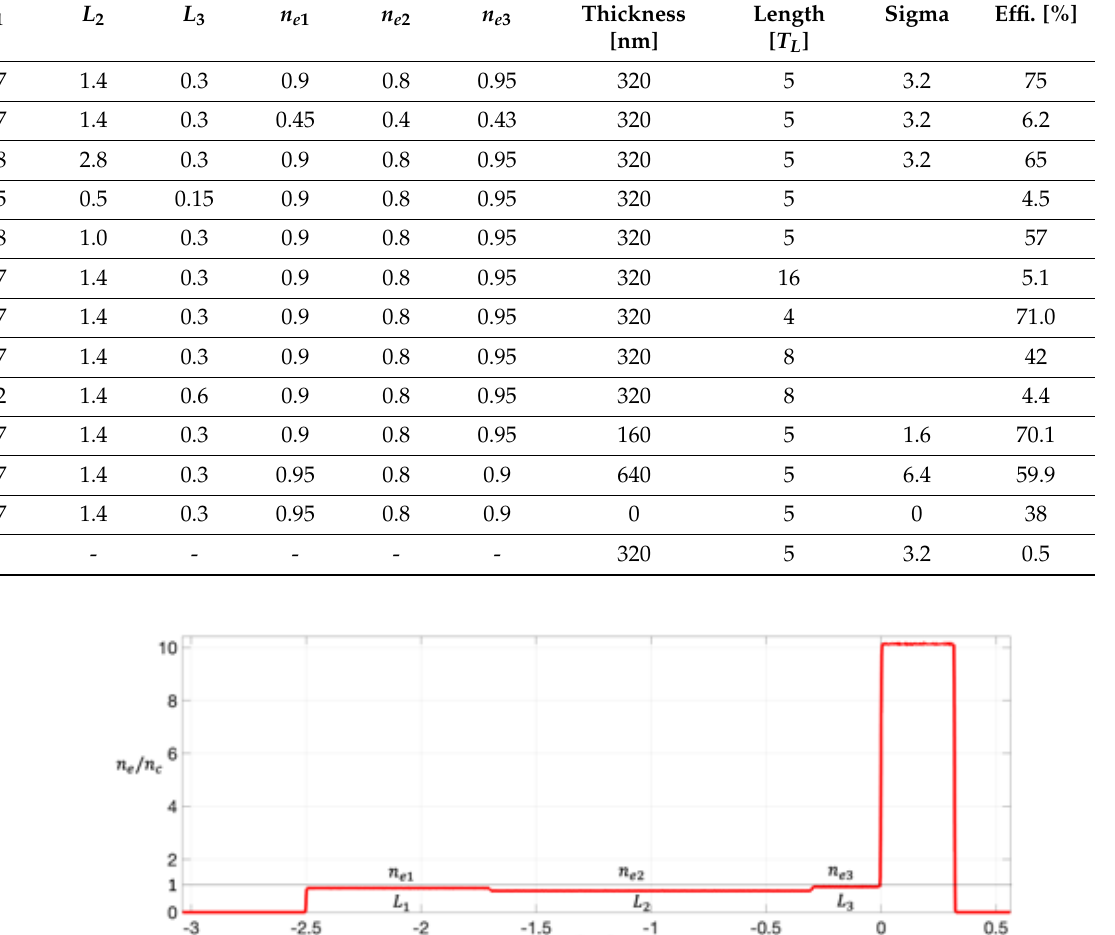
( c ) Figure 2. The evolution of the laser transverse electric field, 𝐸 𝑦 , upon interaction with an overdense foil. The field is normalized to the Tajima-Dawson field, 𝐸 𝑇𝐷 = 𝑚 𝑒 𝑐𝜔 𝐿 /𝑒, where 𝜔 𝐿 is the laser frequency. The laser pulse is reflected and thus minimizing the interaction with the foil and subsequently the conversion efficiency is 0.5%. Laser pulse is injected from the left boundary and at t = 70.06 fs arrives at the foil ( a ), the maximum intensity reaches foil at t = 83.39 fs with the field penetration exhibiting exponential decay into the foil up to a few the skin depth lengths ( b ). Reflected laser pulse shape is slightly modified travelling to the left boundary ( c ). 3. Excited Trapped Waves In Figure 2 we track the evolution of the laser pulse interaction with the foil only; the laser transverse field is black, longitudinal electric field is blue, electron and proton densities are red and green respectively. The laser enters the computational domain at t = 0 from the left, and reaches the foil at a normal incidence at 33.4 fs, as shown in Figure 1. Figure 1 shows the full laser wave packet as a Gaussian irradiating 320 nm thick foil composed of hydrogen plasma at density 𝑛 𝑒 = 10𝑛 𝑐 . In Figure 2b, at 53.4 fs, half of the laser wave packet interacted with the foil compressing the electrons (red) into the foil up to the skin depth ( 𝑐/𝜔 𝑝𝑒 ). Lastly, Figure 2c, at 70.1 fs, shows the full wave pocket reflect and reverse the direction of propagation. Since the thickness of the foil is much greater than the skin depth, very little of the laser field has transmitted. However, we can see the longitudinal electric field (blue) set up at the backside of the foil indicating electrons have penetrated the foil and created the accelerating field. Overall, since the laser-plasma interaction duration is short, the conversion efficiency from the laser to the particles is very low ~0.5%. The photon group velocity, 𝑣 𝑔 = 0, has achieved our objective, however, immediately reaccelerated to the speed of light. Lengthening of the laser-plasma interaction is accomplished by introduction of a subcritical region ( 𝑛 𝑒 < 𝑛 𝑐 ) in front of the over dense foil as shown in Figure 1 which reduces the photon group velocity well below the speed of light. The density is specifically tailored to allow the laser pulse trapping by dividing the region into 3 segments, i.e.,